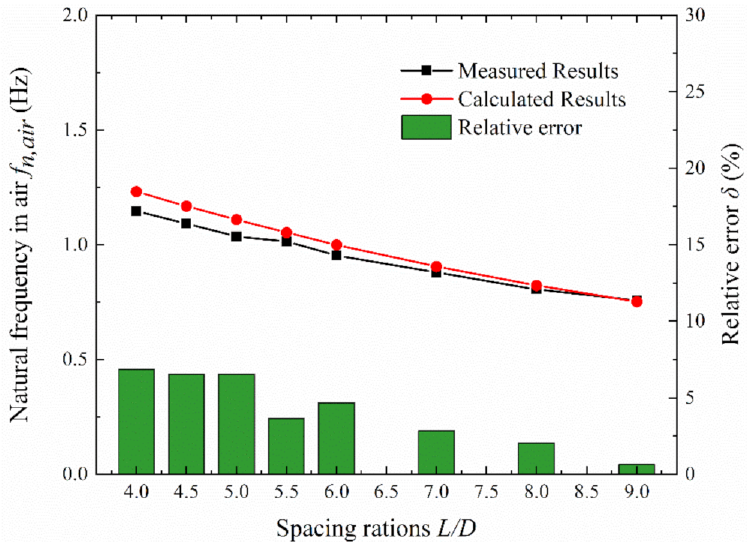
Figure 10. Comparison between experimental and calculated values of system natural